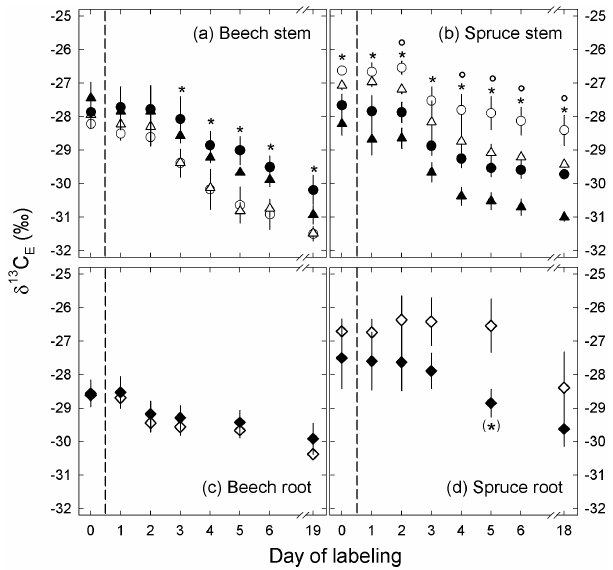
Fig. 2. Course in δ 13 C E of stems (triangles: upper stem, circles: lower stem) and coarse roots (diamonds) of labeled beech (a, c) and spruce (b, d) under 1 × (white) and 2 × O 3 (black) (daily means ± SE, n = 3 trees) during labeling. Consideration was given to the initial difference in δ 13 C E by using data of day 0 as covari- ate. Dashed line indicates the initiation of the label application. Significant differences between O 3 regimes and stem positions at p ≤ 0 . 05 are indicated by * and ◦ , respectively. Marginal signifi- cance at p ≤ 0 . 10 is denoted by (*). Statistical evaluation was per- formed using repeated measures analysis of